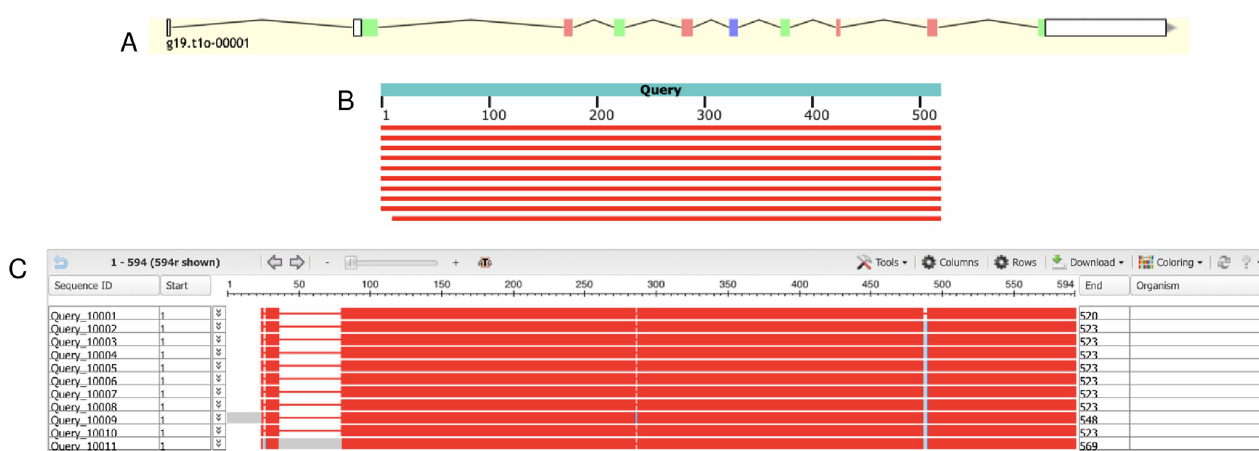
Fig 1. Homology-based genome annotation of the cholesterol side-chain cleavage enzyme. (A) Apollo gene editor view and AUGUSTUS track of the g19.t1 gene located within the ML679947.1 scaffold. (B) Graphical representation of query coverage across the top 10 BLAST hits on 10 subject sequences. Red means high conservation. (C) COBALT multiple sequence alignment demonstrating high conservation (red) across the homologs. Low conservation is colored gray. Exons (thick lines) and introns (thin lines) are shown. Query sequence is the top, while the subjects are below.